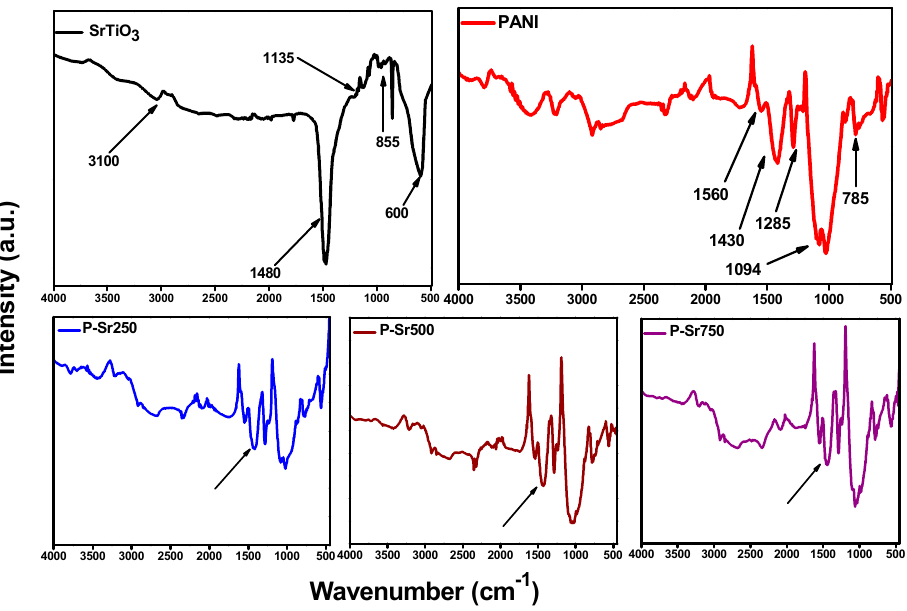
Figure 8. FTIR spectrum of SrtiO 3, PANI and different nanocomposites.